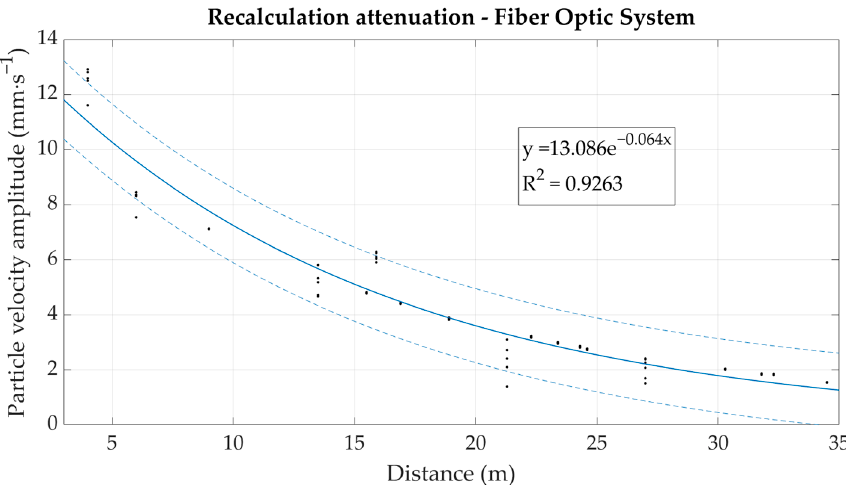
Figure 11. Graphical representation of the environmental attenuation based on the recalculated values measured by the optical interferometer.